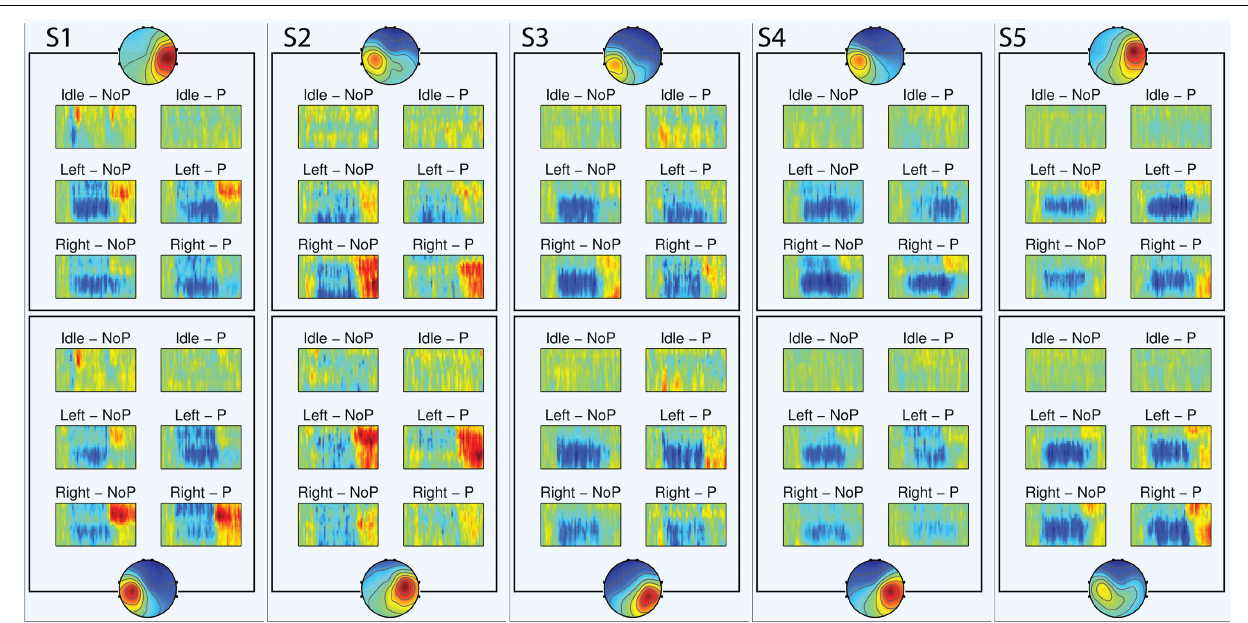
FIGURE 6 | ERSP visualization. In each ERSP image, the abscissa represents the time ( − 0.3 to + 4.3s), while the ordinate represents the frequency (from 8 to 30Hz), the red color portrays power increase with respect to the baseline (dB), while the blue color power decrease (dB). For each subject, only the ERSP of the spatial filters with a selection ratio r = 100% are visualized. The figure is organized so that it is